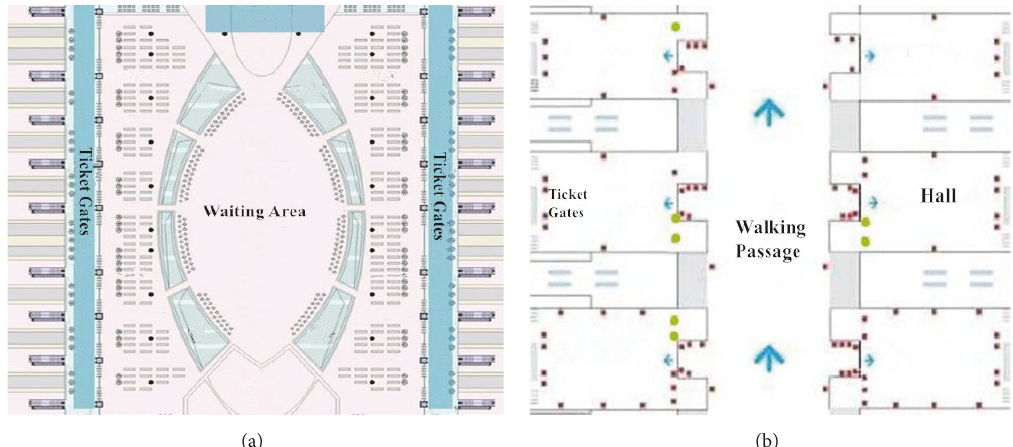
Figure 1: The sketches of the waiting hall, where (a) is the HSR waiting hall and (b) is the conventional railway waiting hall.